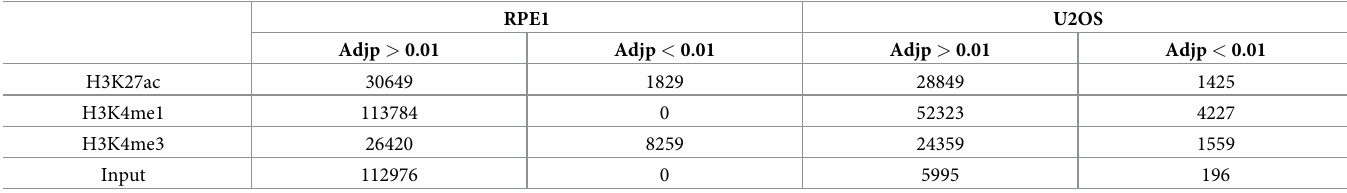
Table 10. The performances achieved by DESeq2 applied to the present data set. Adjp: adjusted P -values computed by DESeq2. RPE1 U2OS Adjp > 0.01 Adjp < 0.01 Adjp > 0.01 Adjp < 0.01 H3K27ac